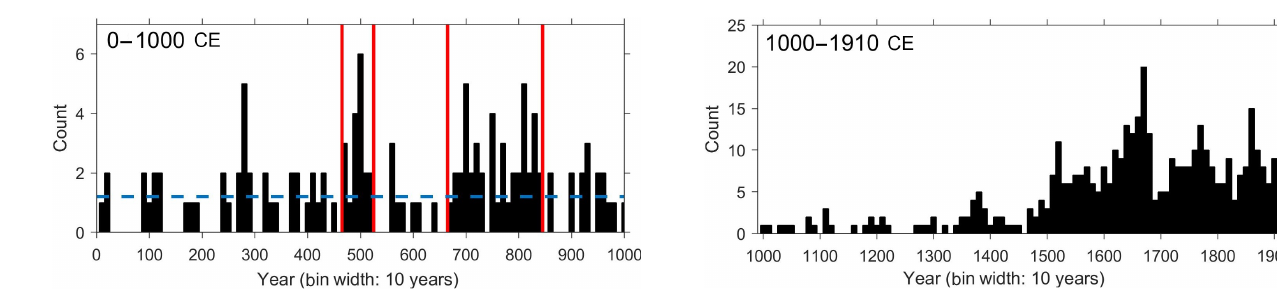
Figure 3. Statistics showing the number of typhoons between 0 and 1000CE. The red range means high-frequency periods of TCs.